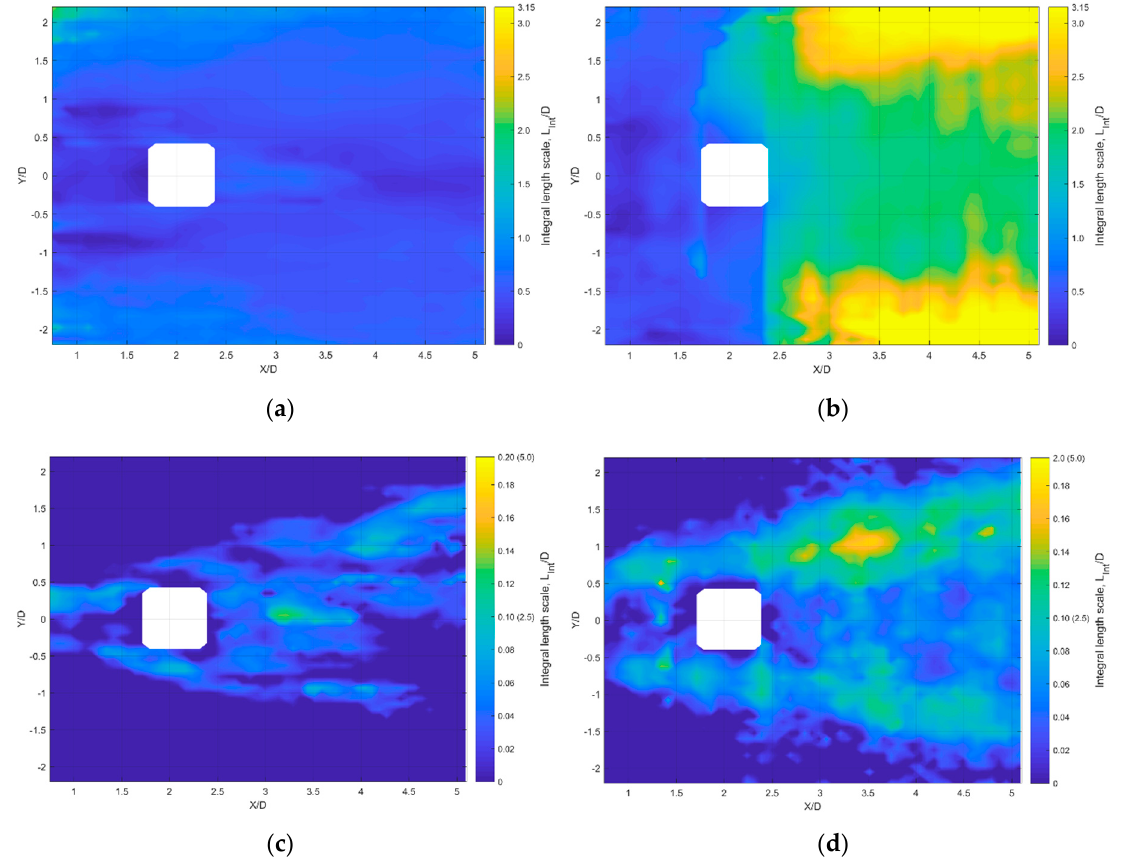
Figure 16. Integral length scales associated with ( a , b ) coherent fields, 1 L 11 and 2 L 22 respectively; ( c , d ) turbulent fields, 1 L 11 and 2 L 22 respectively. Note colour scale changes between subfigures. Parentheses values in ( c ) and ( d ) are mm.